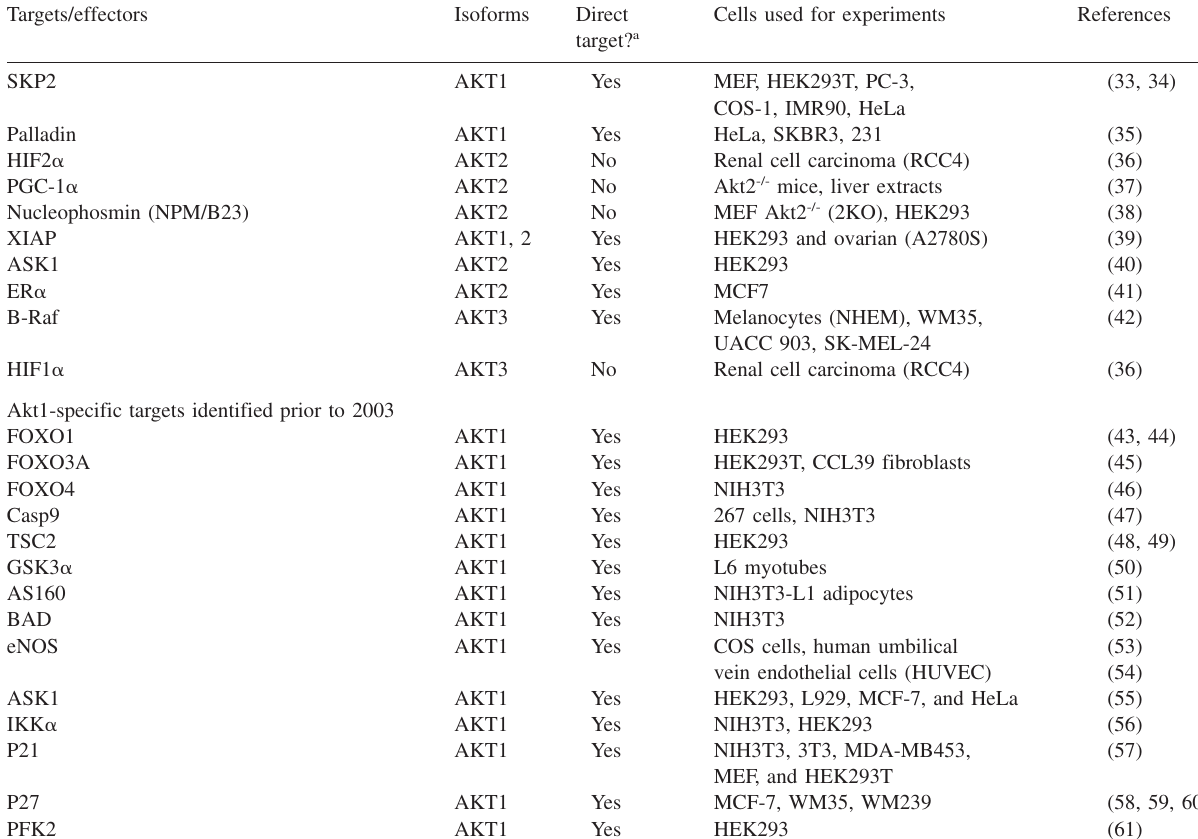
Table 1 Summary of Akt targets and downstream